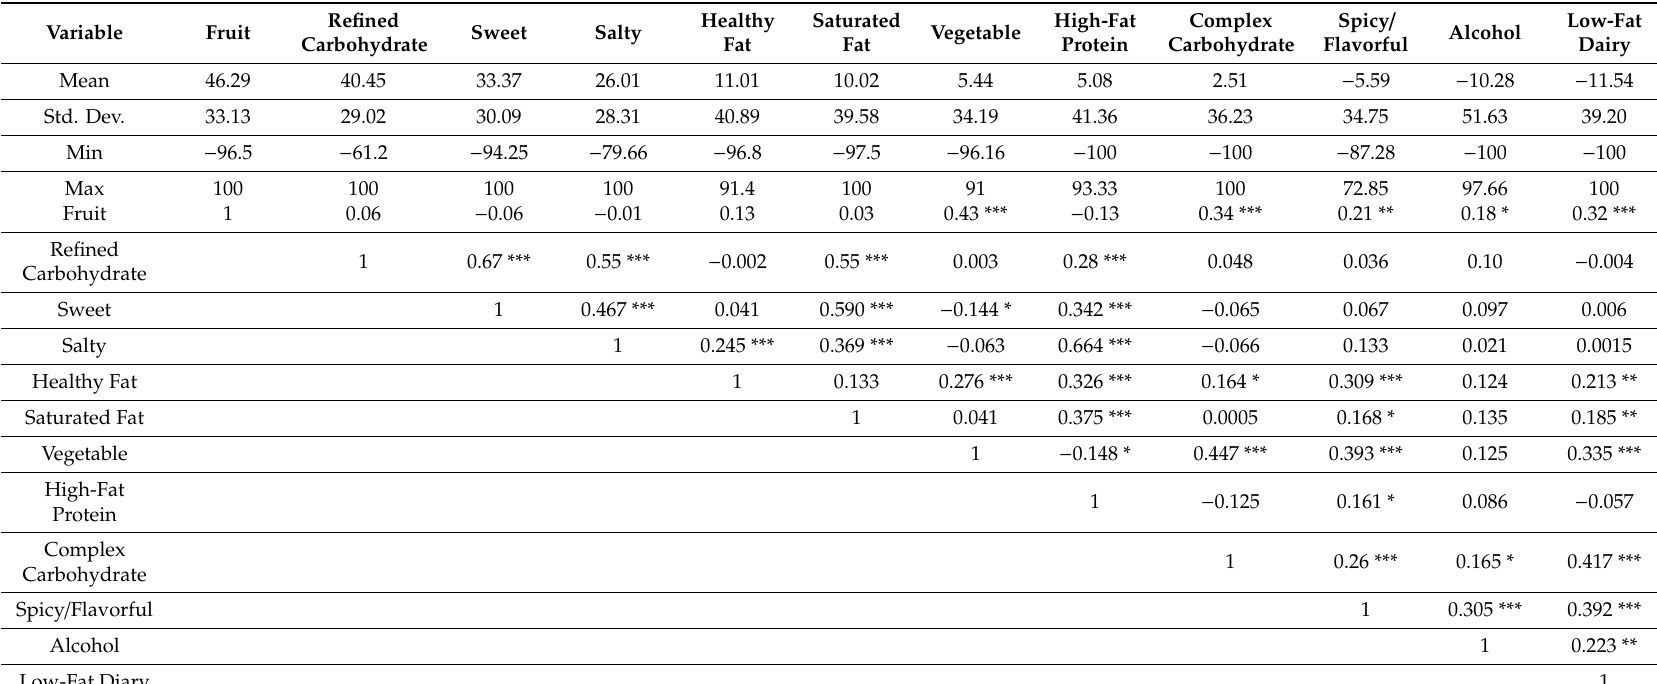
Table 3. Descriptive statistics and pairwise correlations among all nutritional